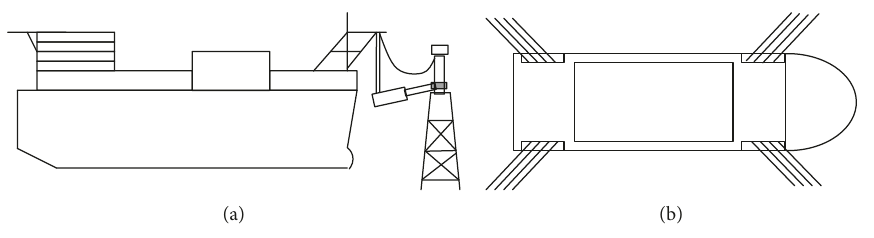
Figure 1: Feasible mooring scheme of OFNPP: (a) single point mooring and (b) spread